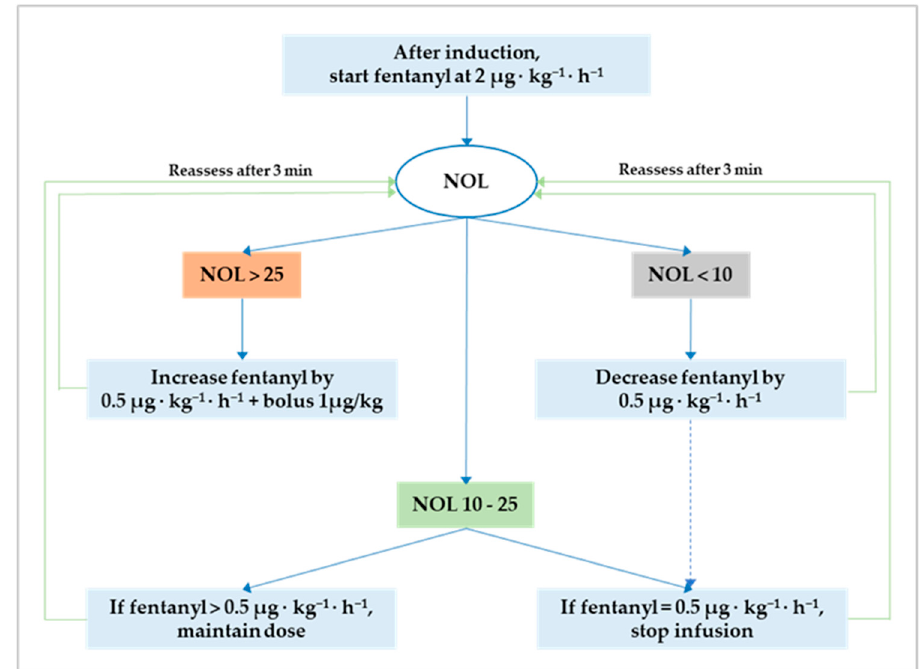
Figure 1. Flowchart for NOL index-based fentanyl administration. The optimum nociception– antinociception balance is a NOL index between 10 and 25. Outside this range, fentanyl should be either decreased to avoid overdosing (i.e., NOL index < 10) or increased to prevent underdosing and nociception (i.e., NOL index > 25). NOL, nociception level.